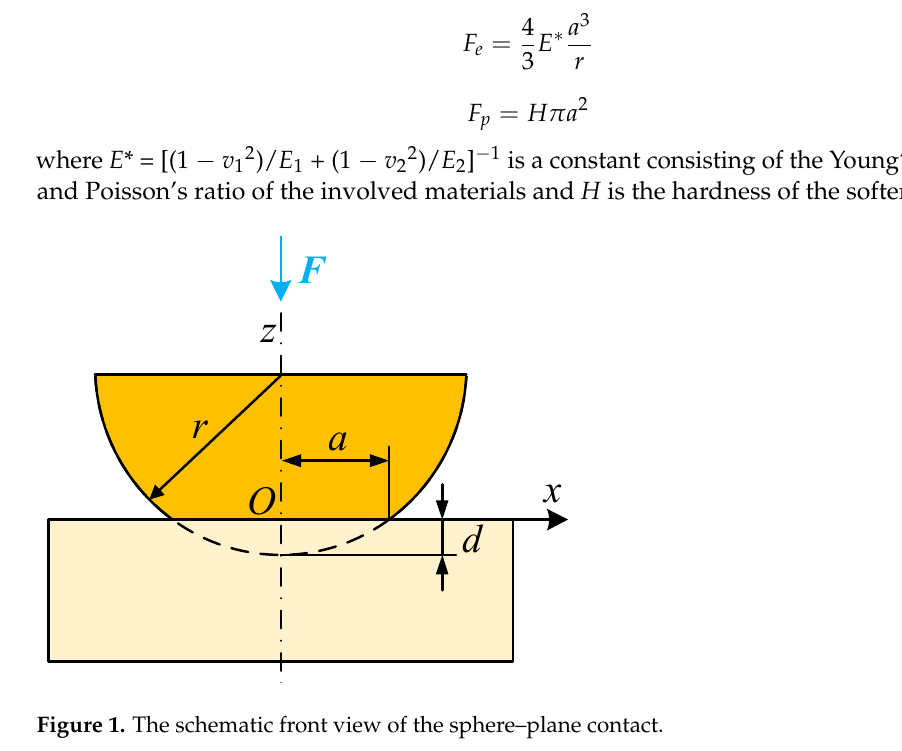
Figure 1. The schematic front view of the sphere–plane